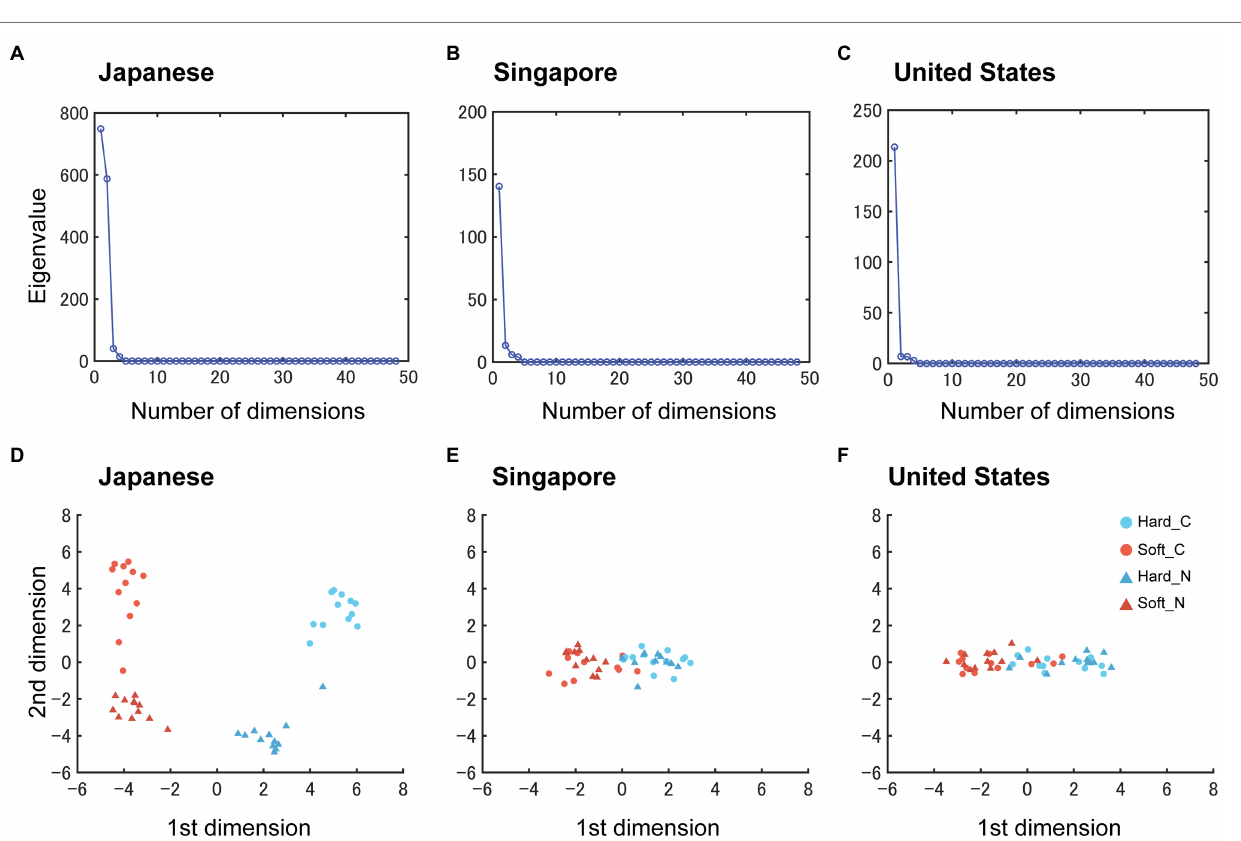
FIGURE 5 | Multidimensional Scaling (MDS) of each country data. (A–C) , Scree Plots for the Japanese, Singaporean, and US subjects, respectively. The scales of the y -axes in (B,C) were adjusted for presentation purposes. (D–F) , 2D MDS solutions for the Japanese, Singaporean, and US subjects, respectively. Each dot represents a sound-symbolic